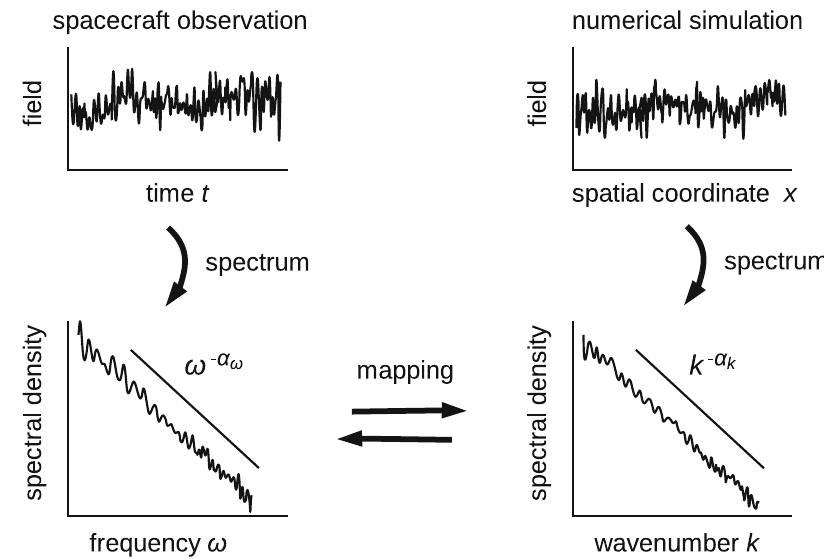
Fig. 1 Mapping of the one-dimensional energy spectrum between the frequency domain for the spacecraft observation and the wavenumber domain for the numerical